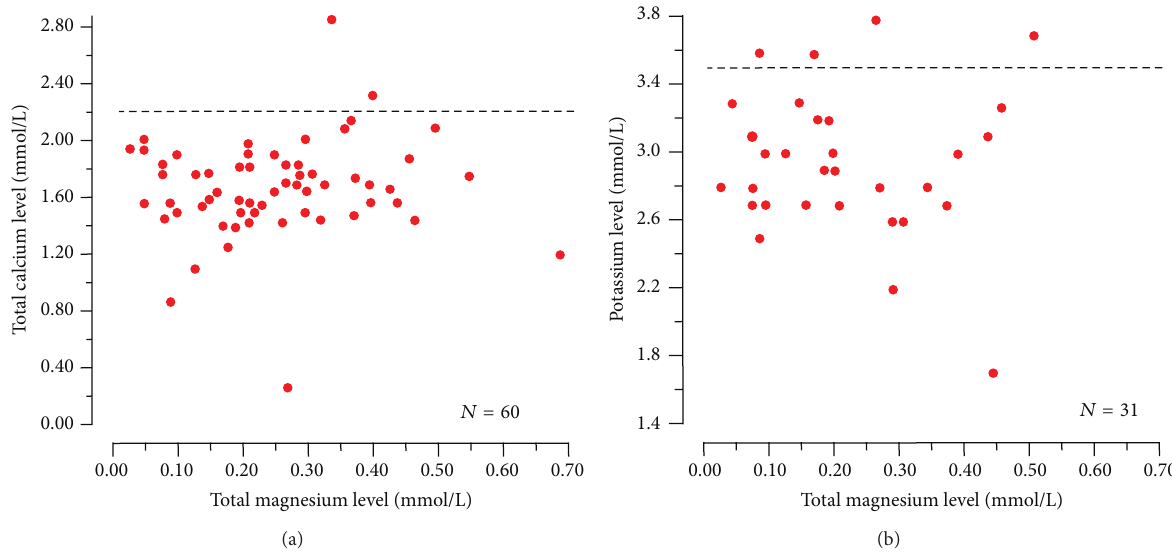
Figure 2: Relationship between circulating magnesium and total calcium (left panel) or potassium (right panel) in patients with proton-pump inhibitor associated hypomagnesemia. None of the correlations was found to be significant. The horizontal dotted lines denote the threshold level of hypocalcemia (2.20 mmol/L) and hypokalemia (3.5 mmol/L), respectively.